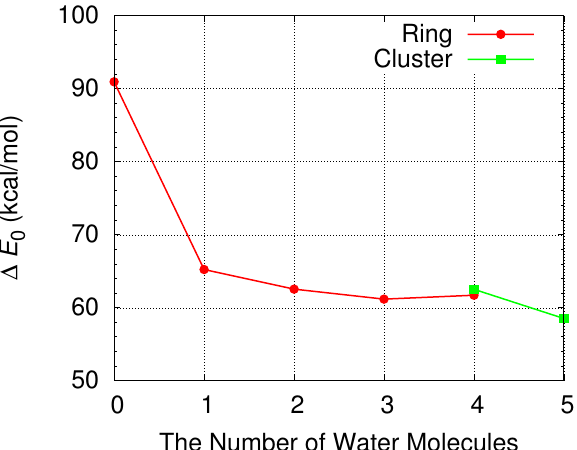
Figure 9. The energy barrier for the oxidation of a CH OH in water when H O molecules in a ring 3 2 structure and a cluster of H O molecules catalyze the oxidation of a CH OH. The energy barrier is 2 3 calculated from the difference of the electronic energies corrected by the zero point energy between a transition state and a reactant